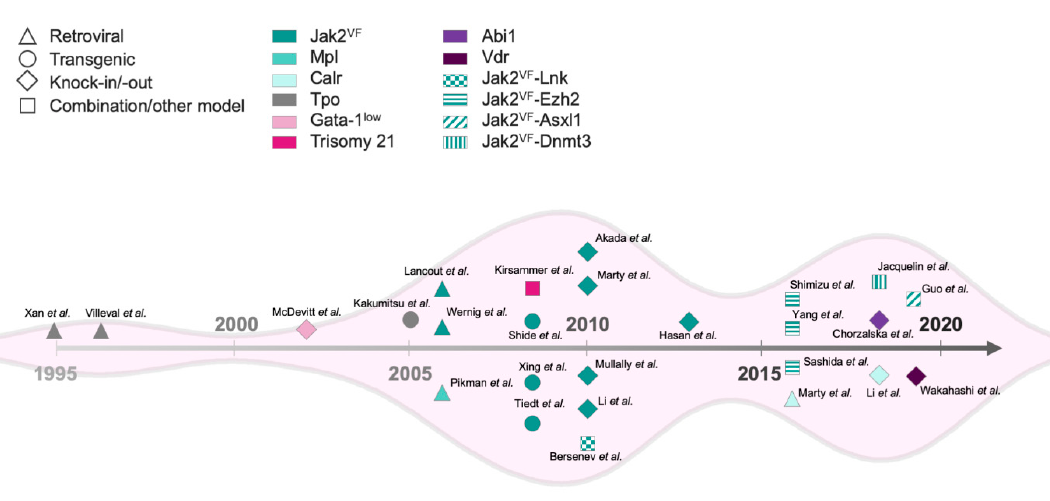
Figure 1. Timeline of published myelofibrosis mouse models.